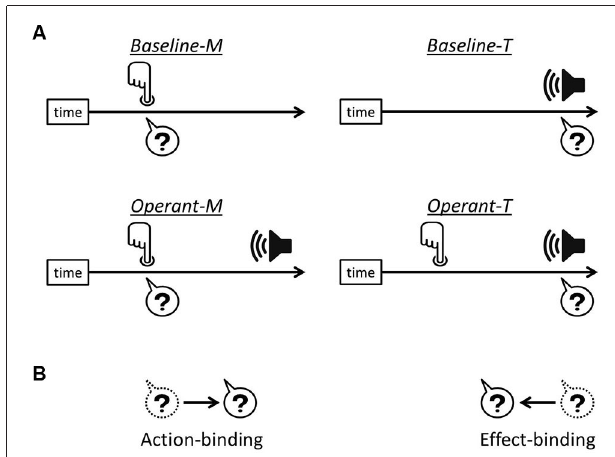
FIGURE 1 | Intentional binding paradigm. (A) In each task, participants reported either finger movement time or the onset time of the tone, indicated by the question marks. In operant tasks, i.e., Operant-M and Operant-T , a voluntary finger movement causes the tone effect 250 ms after. (B) Action-binding represents the temporal attraction of finger movement time towards the tone onset in operant-M relative to baseline-M , while effect-binding represents the temporal attraction of the tone onset time towards the onset of finger movement in operant-T relative to baseline-T